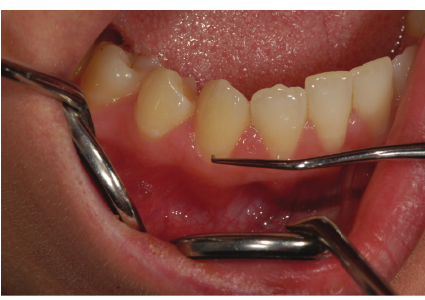
Figure 2: Tactile stimulus